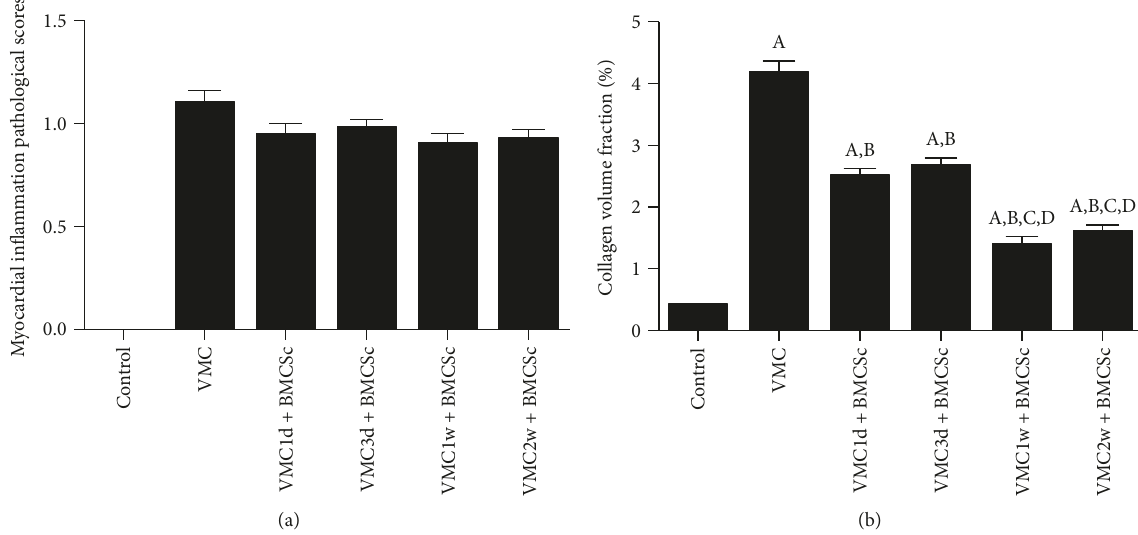
Figure 2: (a) The fi gure presented the myocardial in fl ammation pathological scores in di ff erent groups and subgroups. The di ff erence among the groups was not statistically signi fi cant. (b) The collagen volume fraction of myocardial tissues. A P < 0 05 when compared to the control group; B P < 0 05 when compared to the VMC group; C P < 0 05 when compared to the VMC1d +BMSCs subgroup; and D P < 0 05 when compared to the VMC3d+BMSCs subgroup.